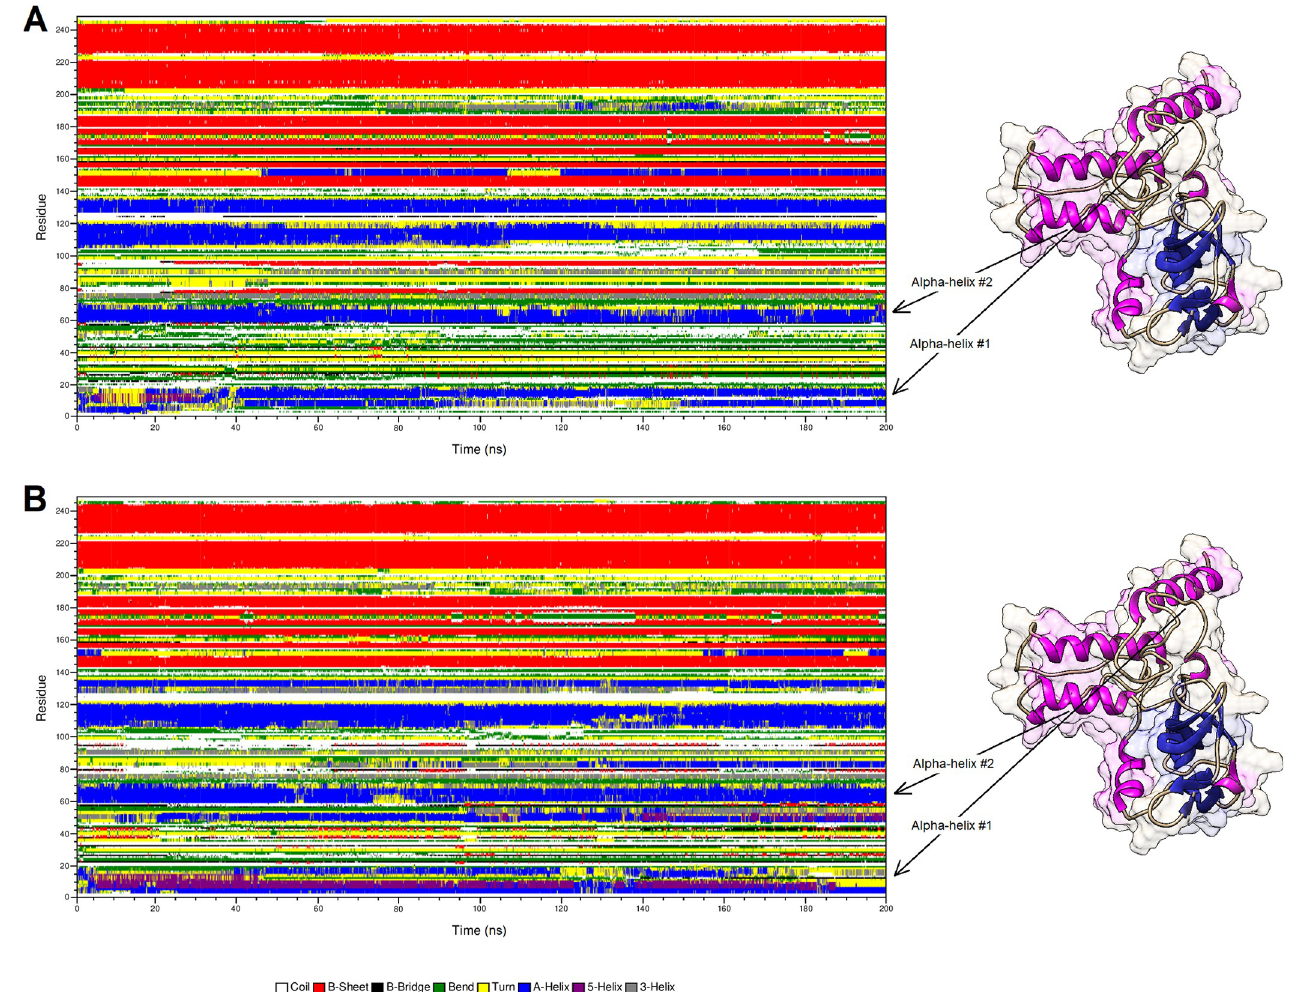
Fig 15. Secondary structure analysis of BDNF wild-type and its V66M variant. Time evolution of secondary structural elements during the MD simulations of wild-type BDNF (A) and its V66M variant (B). Coils are represented in white, β -sheets are represented in red, β -bridges are represented in black, bends are represented in green, turns are represented in yellow, α -helices are represented in blue, 5-helices are represented in purple and 3-helices are represented in gray.